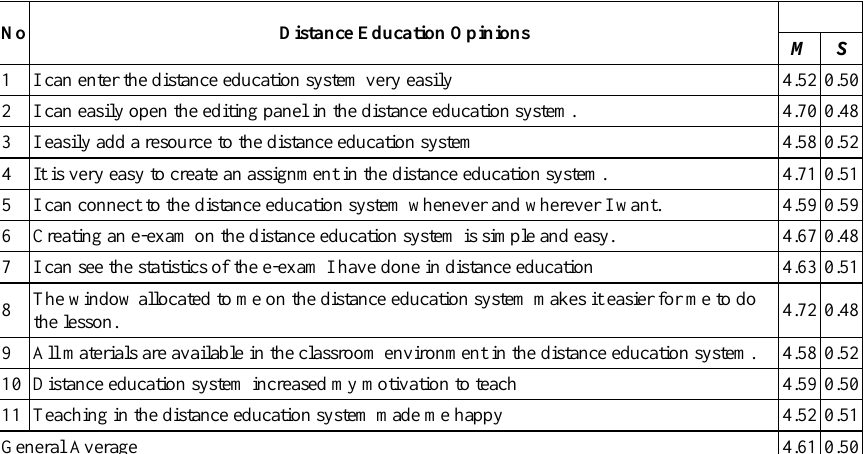
Table 5. Opinions of academicians about distance